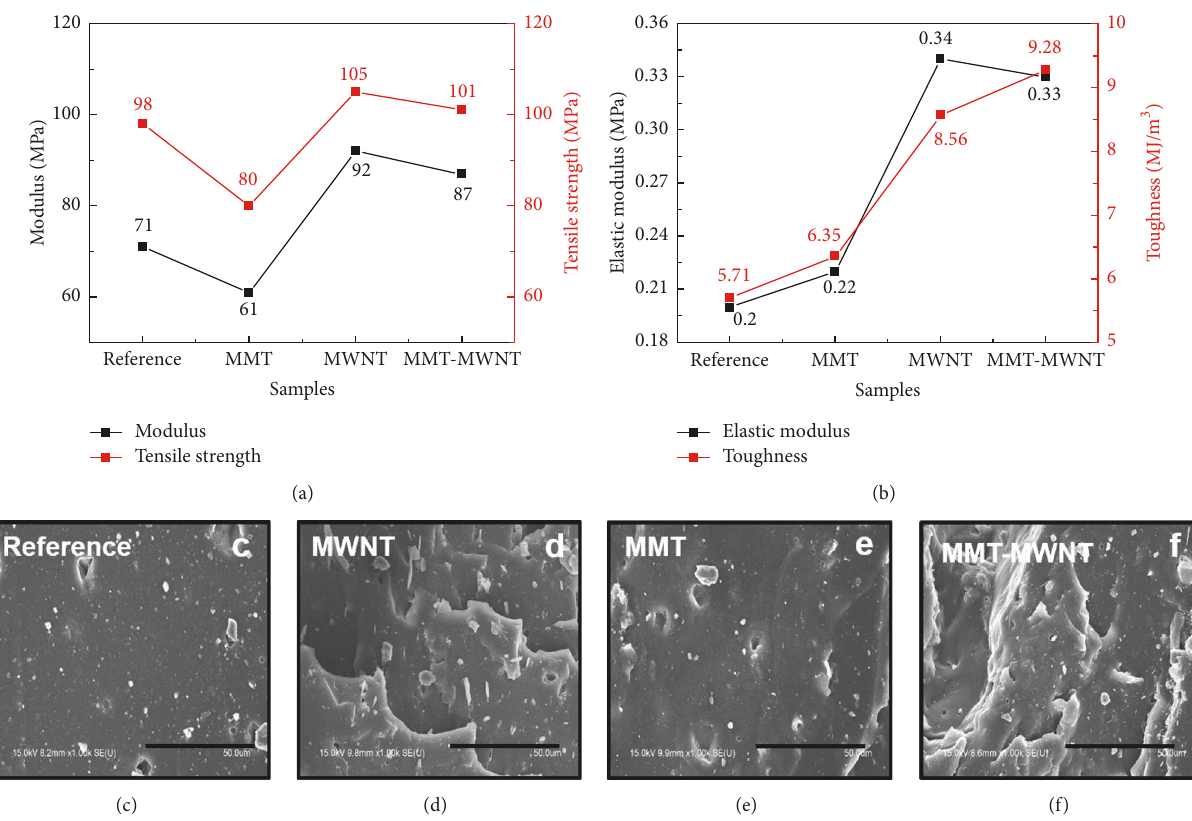
Figure 3: Mechanical properties of elastomer nanocomposites. (a) Stress-strain curves of the elastomer nanocomposites with diverse fillers. (b) Elastic modulus and toughness of the elastomer nanocomposites with diverse fillers. ((c), (d), (e), and (f)) SEM images of fracture surface of elastomer nanocomposites with reference, MMT, MWNT, and MMT/MWNT,